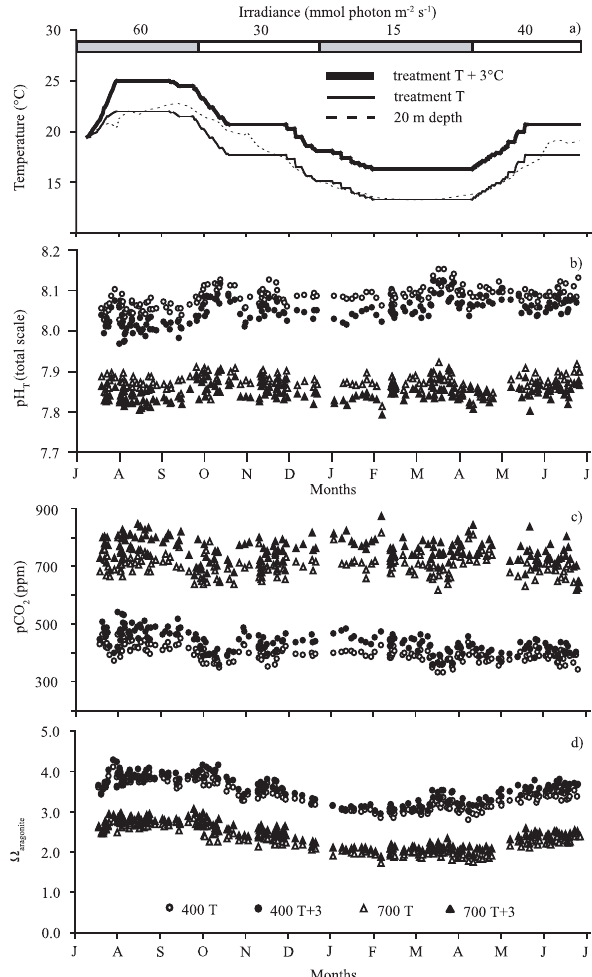
Fig. 1. (a) seasonal variation of temperature and irradiance in the Bay of Villefranche (mean between 1995 and 2006 at 20m depth; data from SO-Rade, Service d’Observation Rade de Ville- franche of the Observatoire Oc´eanologique and SOMLIT, Service d’Observation en Milieu Littoral , CNRS, INSU) and in the experi- mental aquaria; (b) pH T , (c) p CO 2 , and (d) CaCO 3 saturation state ( (cid:127) aragonite ) of seawater during the one-year experiment for each treatment (400 T , 400 T +3, and 700, 700 T +3; n = 191 to